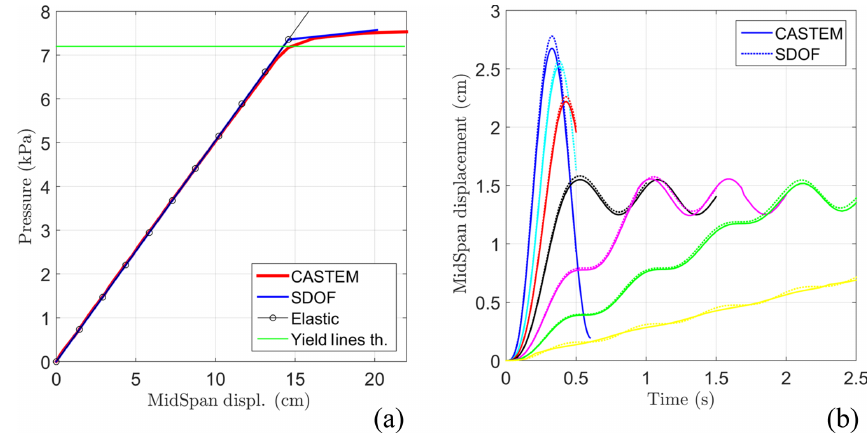
Figure 7. Comparisons of (a) FEA (CASTEM), SDOF models, and ultimate load prediction by yield lines theory in the case of a quasi-static pushover test; and (b) time evolution of the mid-span displacement ( v 0 ) of the RC wall for several loading times ( t end red: 0.3, black: 0.5, magenta: 1, green: 2, yellow: 5s).